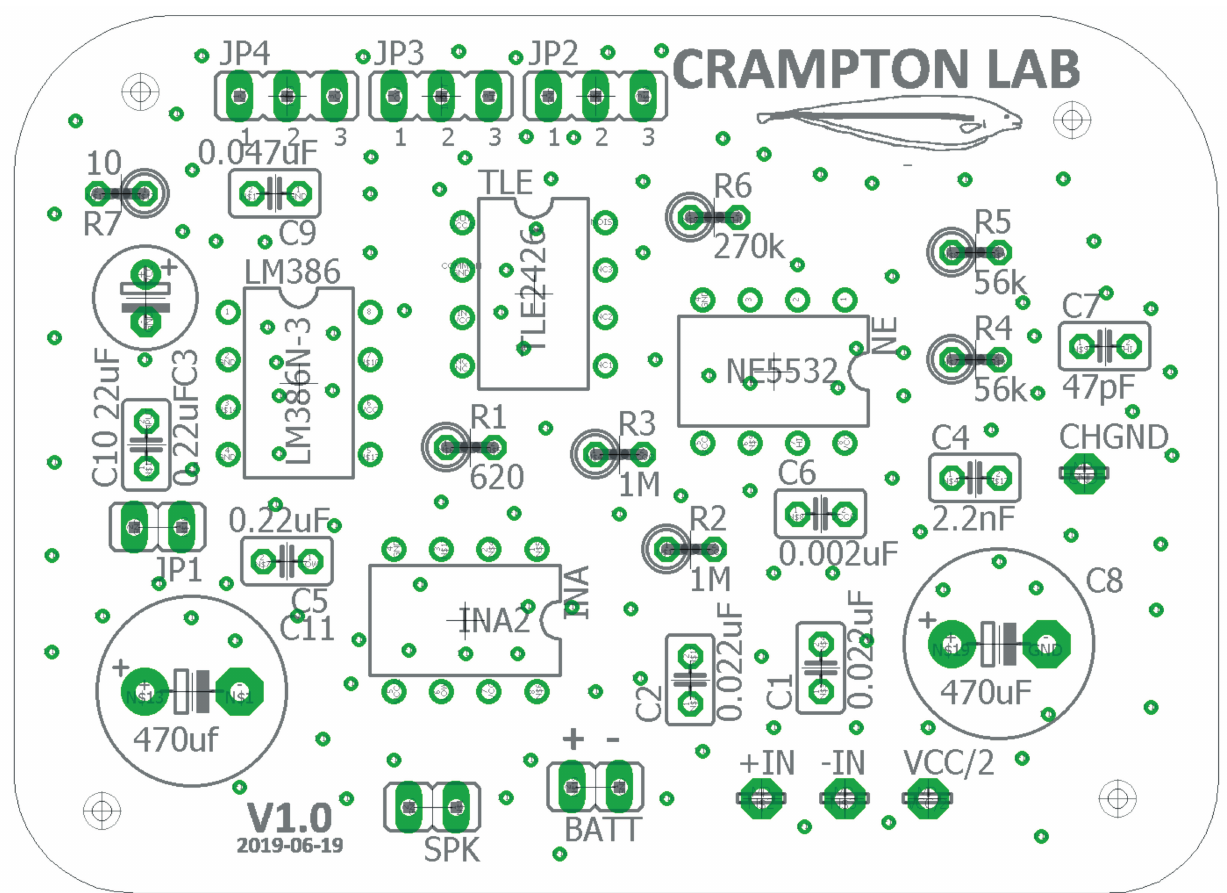
Fig. 2. Electric fish finder printed circuit board layout in Autodesk Eagle format. For abbreviations see Fig. 1 legend. This layout matches the circuit schematic in Fig.